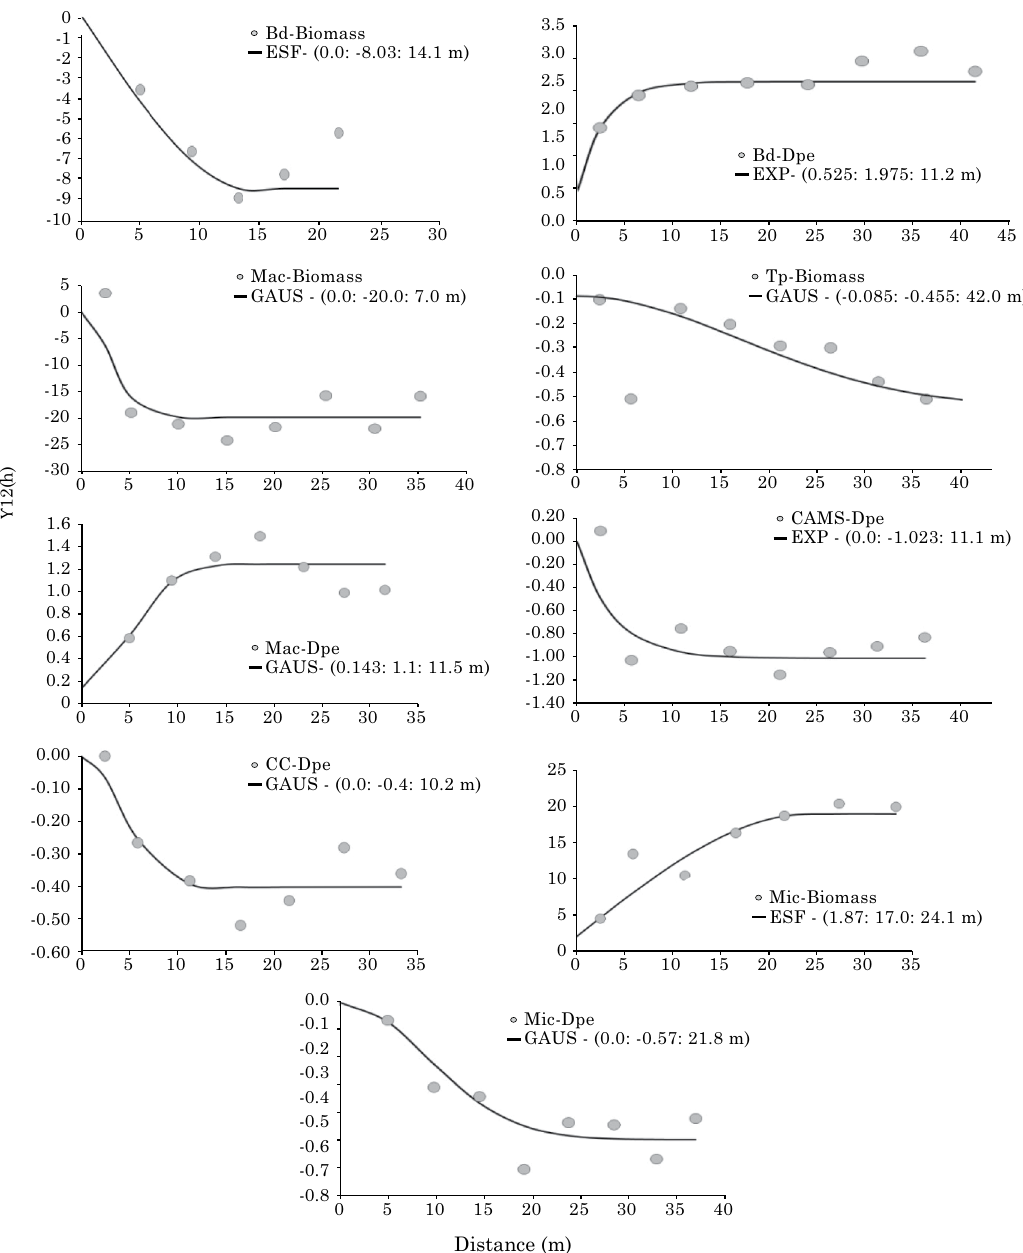
Figure 2. Cross variograms and mathematical models adjusted to weed variables and soil physical properties in conventional tillage. Bd: soil bulk density (kg dm -3 ); Tp: total porosity (m 3 m -3 ); Mac: macroporosity or equivalent of pores drained at -60 hPa tension (m 3 m -3 ); Mic: microporosity (m 3 m -3 ); CAMS: pores drained at -100 hPa tension (m 3 m -3 ); CC: estimated water content at -100 hPa tension (m 3 m -3 ); Dpe: weed density (plants m -2 ); biomass: dry matter of weed shoots (g m -2